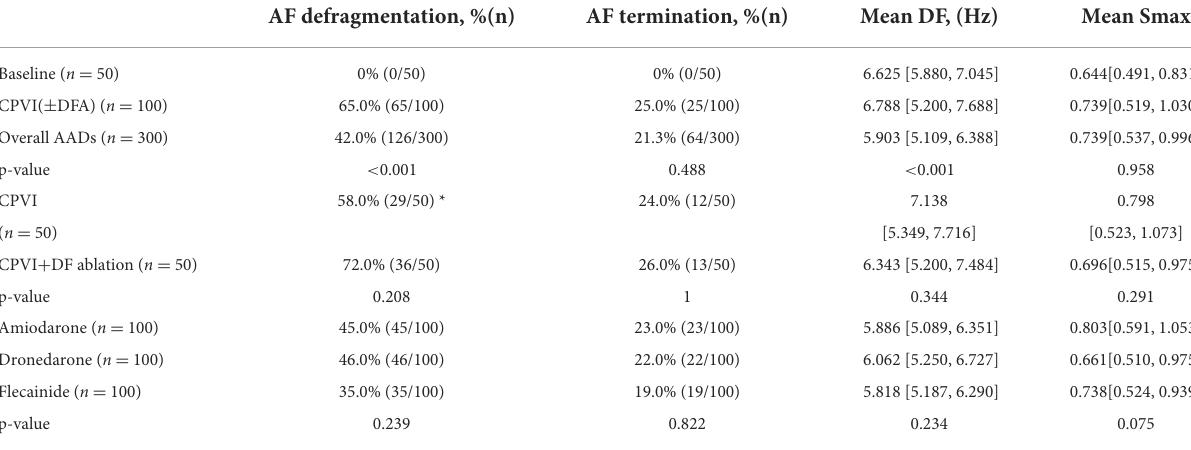
TABLE 1 Defragmentation rate and wave-dynamic changes in the overall AF episodes (Wild type and PITX2 + / −